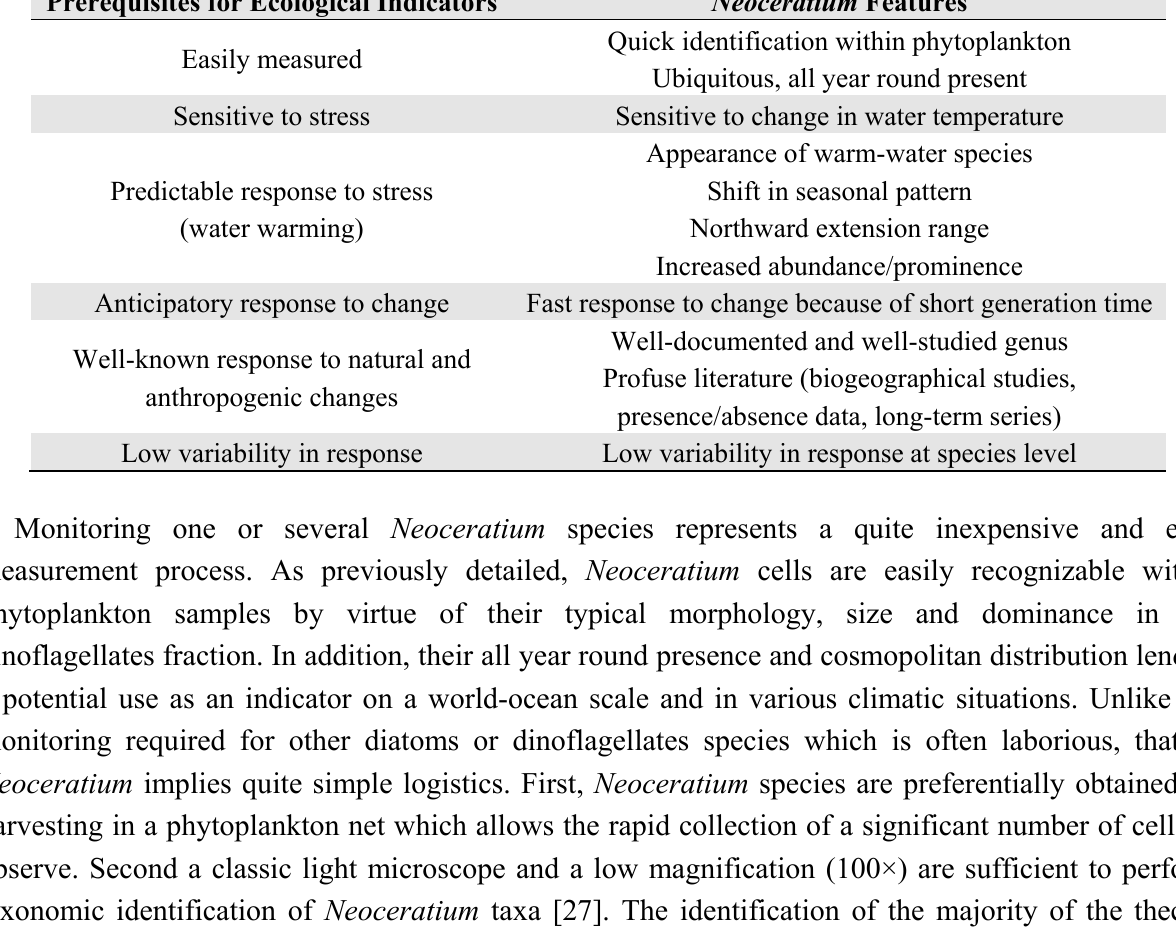
Table 2. Neoceratium features that match the prerequisites for ecological indicator validation. Prerequisites for Ecological